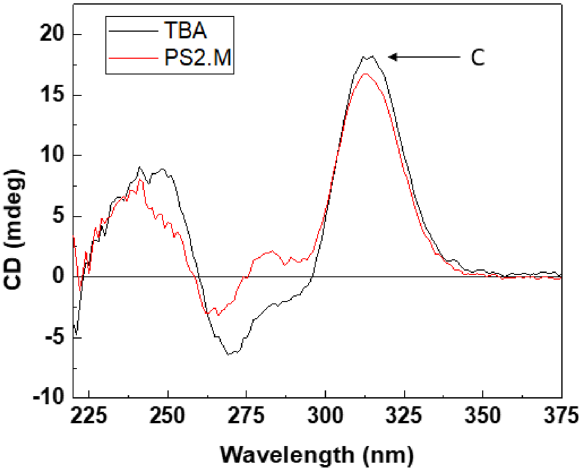
Figure 6. CD spectra of TBA and PS2.M by Pb 2+ in the presence of multiple ions, Al 3+ , Cu 2+ , Ni 2+ , Fe 3+ , Co 2+ , Cr 2+ and Sr 2+ . Each ion concentration including Pb 2+ is 3 μM, without K + . Peak C indicated the 314 nm peaks of two G-QDs induced by Pb 2+ .